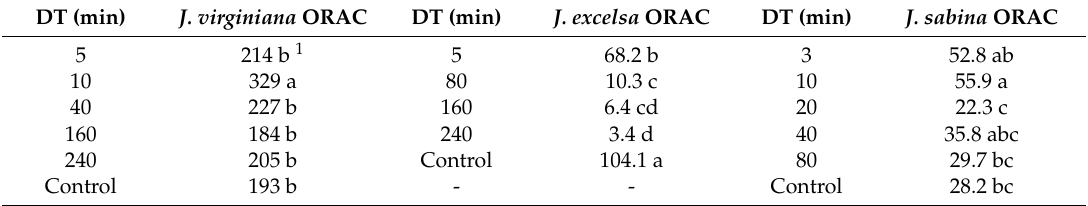
Table 9. Mean oxygen radical absorbance capacity (ORAC) value (uM Trolox Equiv/per g oil) in Juniperus virginiana , J. excelsa , and J. sabina obtained from different distillation times